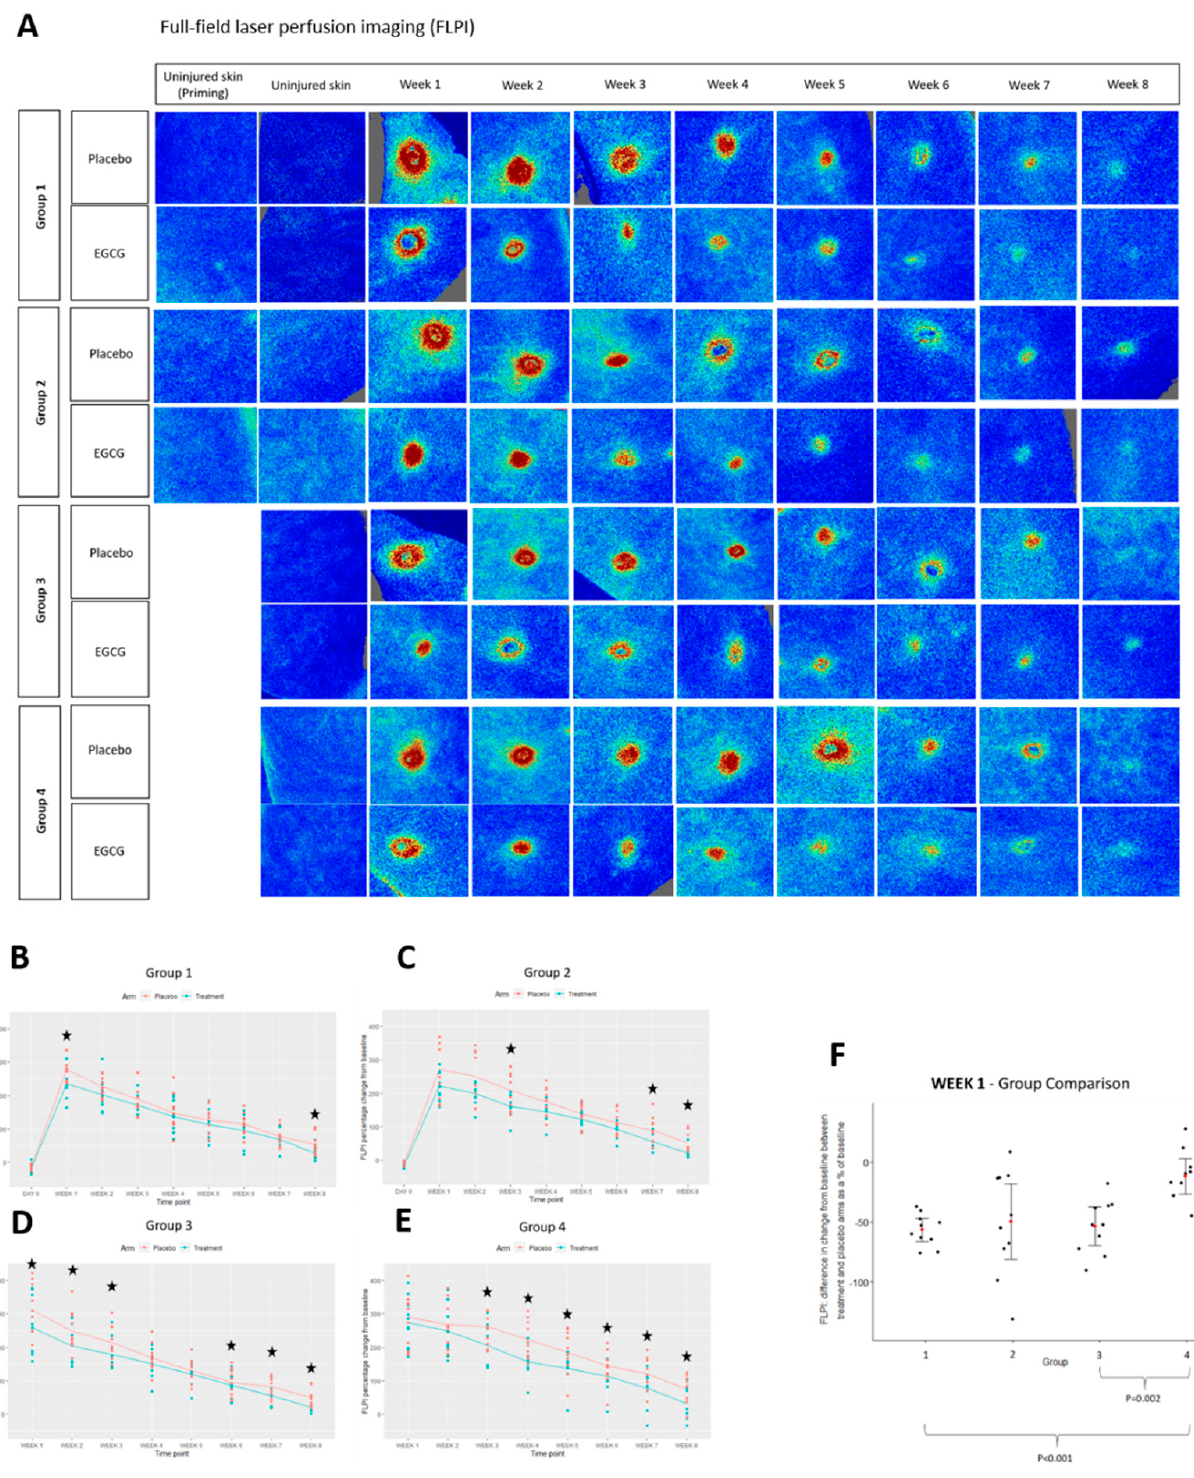
Figure 13. Clinical analysis of blood flow using non-invasive objective device; full-field laser perfusion imaging (FLPI). ( A ) FLPI images of epigallocatechin-3-gallate (EGCG) compared to placebo in all groups. ( B ) Group 1 FLPI measurements. ( C ) Group 2 FLPI measurements. ( D ) Group 3 FLPI measurements. ( E ) Group 4 FLPI measurements. ( F ) Between group comparison analysis for FLPI at week 1. Significance: ★ p ≤ 0.01.